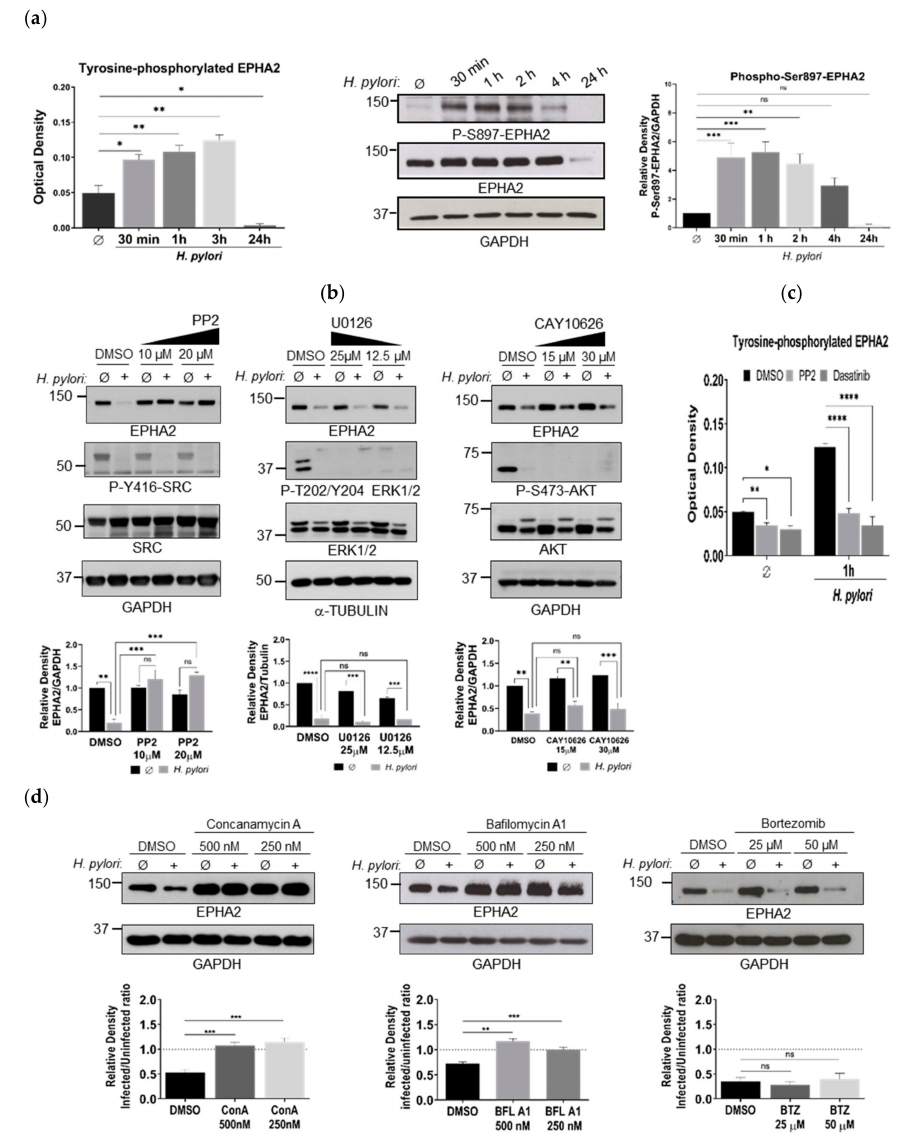
Figure 2. EPHA2 receptor downregulation induced by H. pylori infection is preceded by receptor phosphorylation early on and is followed by lysosomal degradation in the MKN74 gastric cell line. ( a ) Tyrosine and serine897 phosphorylation of EPHA2 upon H. pylori exposure, as determined by ELISA and Western blot, respectively; *** p < 0.001, ** p < 0.01, * p ≤ 0.05, ns—not significant ( p > 0.05). ( b ) E ff ect of PP2 (SRC family kinase inhibitor), U0126 (MEK inhibitor), and CAY10626 (PI3K α / mTOR inhibitor) on downregulation of EPHA2 mediated by H. pylori at 24 h by Western blot and corresponding quantifications by densitometry; **** p < 0.0001, *** p < 0.001, ** p < 0.01, ns—not significant ( p > 0.05). ( c ) E ff ect of SRC family kinase inhibitors (PP2 and Dasatinib inhibitors) on EPHA2-tyrosine phosphorylation 1 h after H. pylori infection, as evaluated by ELISA; **** p < 0.0001, ** p < 0.01, * p ≤ 0.05. ( d ) E ff ect of lysosomal (Bafilomycin A1 and Concanamycin A) and proteasomal (bortezomib) inhibitors on EPHA2 receptor downregulation induced by H. pylori at 24 h post-infection as shown by Western blot and the respective relative density expressed as the ratio of infected / uninfected cells; *** p < 0.001; ** p < 0.01; ns—not significant ( p > 0.05). One-way ANOVA with post-hoc Dunnett’s or Tukey’s